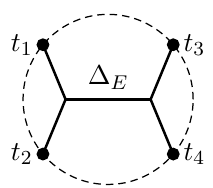
Figure 5 . Tree diagram associated with the s-channel exchange of a field with conformal parameter ∆ E mediated by two cubic vertices. The dashed line is just a convenient graphical representation for the compactified boundary of AdS 2